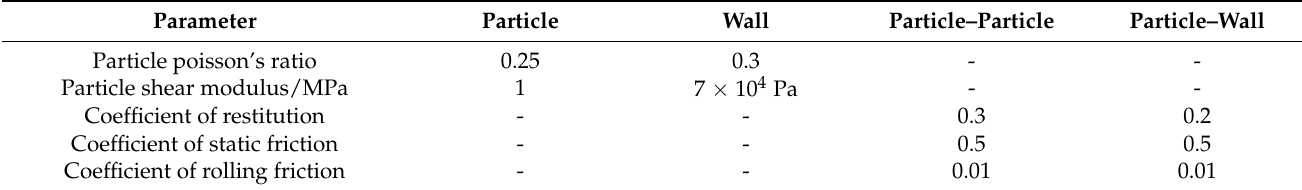
Table 2. Property of particles and wall in